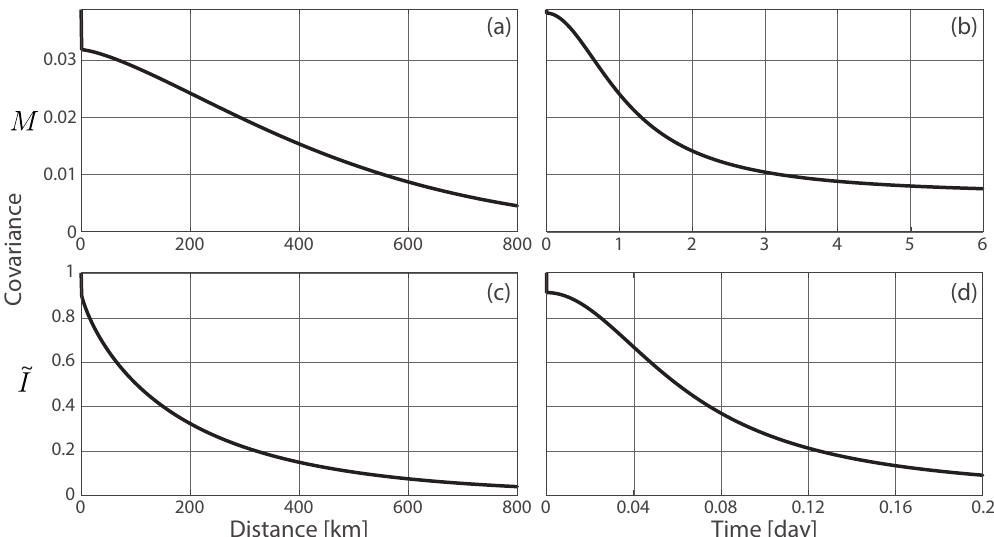
Figure A5. Illustration of the calibrated covariance function of the multi-night scale M ( a , b ) and the intra-night scale ˜ I ( c , d